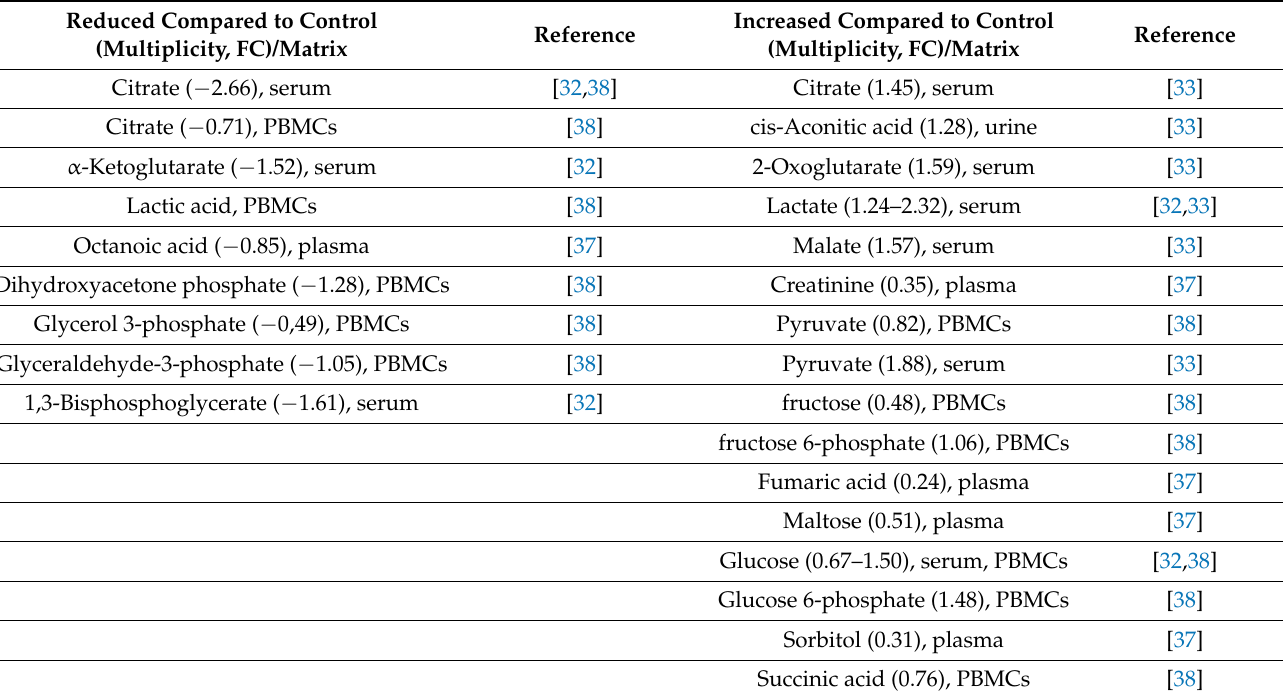
Table 3. Differentiating between schizophrenic patients and healthy controls carbohydrate and TCA cycle